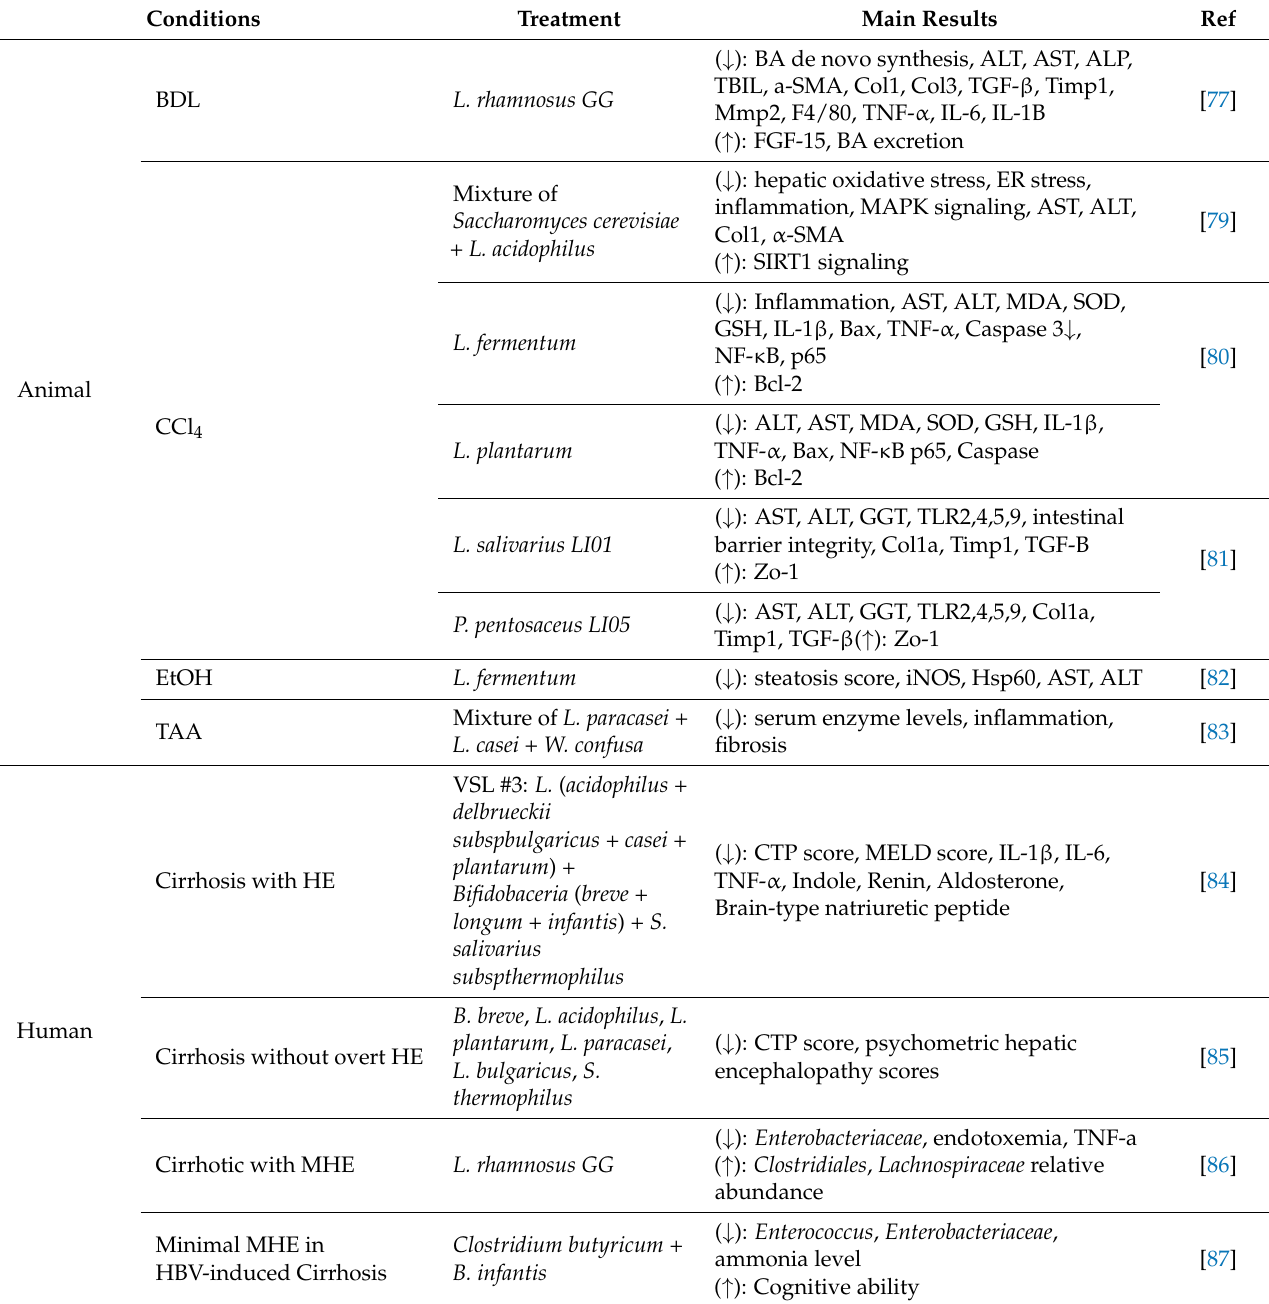
Table 2. Animal and human studies using